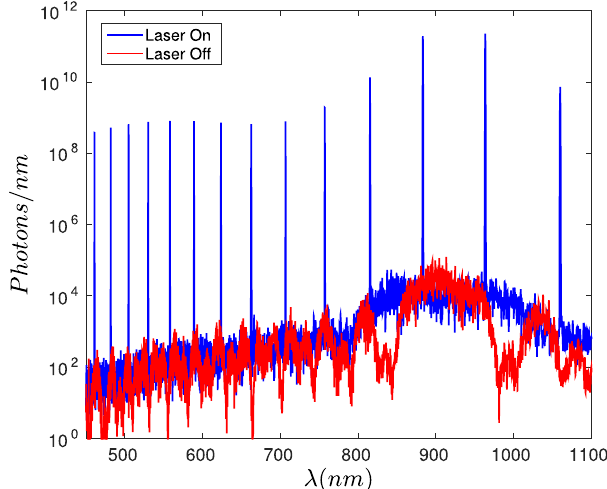
FIG. 9. The resultant power spectrum from the proposed experimental setup at the ATF. The y-axis is the number of photons per nm bandwidth. Spectral brightness is increased by 6 orders of magnitude for the laser harmonics, while integrated radiation energy is increased by roughly 4 orders of